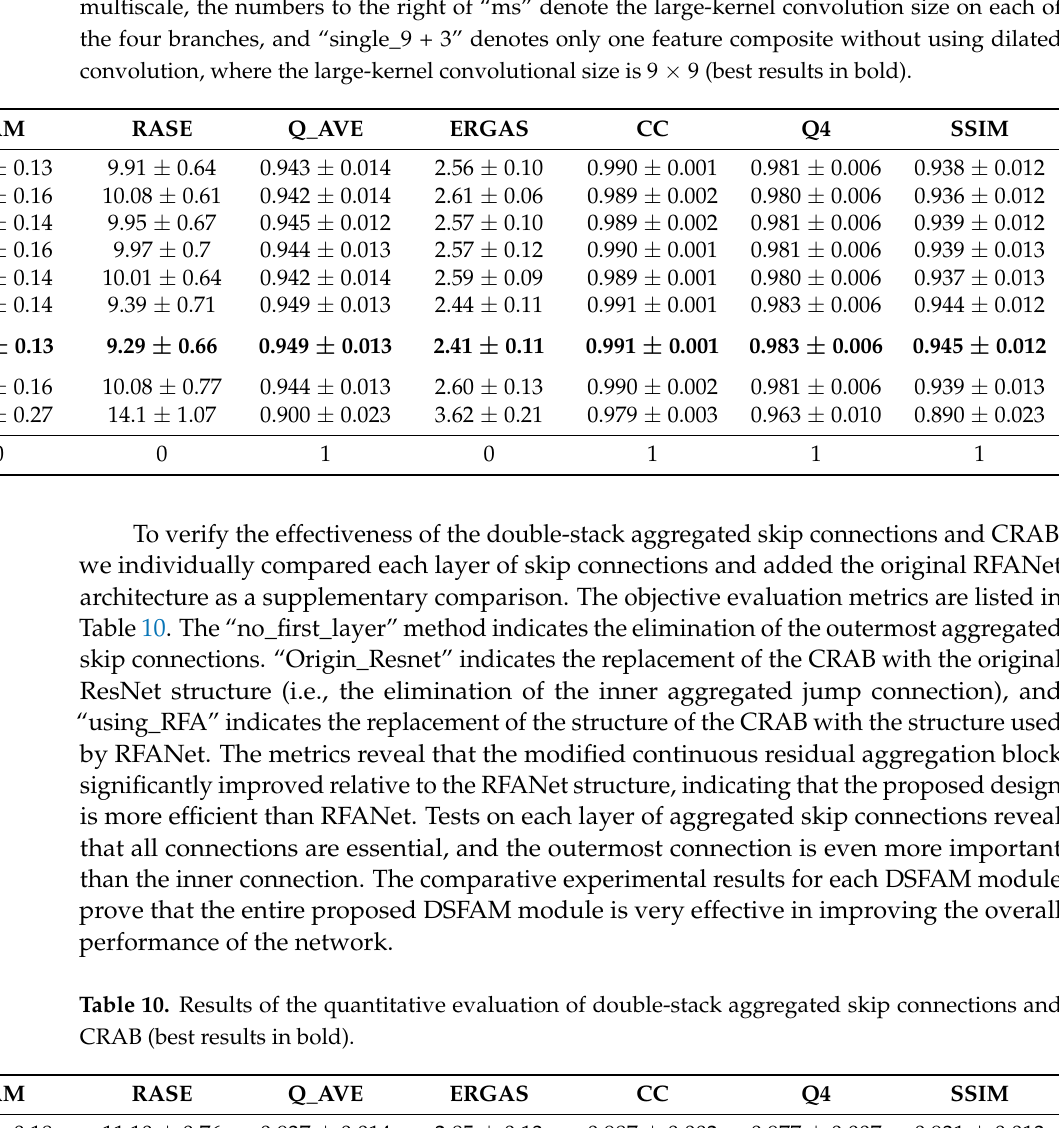
Table 9. Quantitative evaluation results of MLRB under different combinations, where “ms_” denotes multiscale, the numbers to the right of “ms” denote the large-kernel convolution size on each of